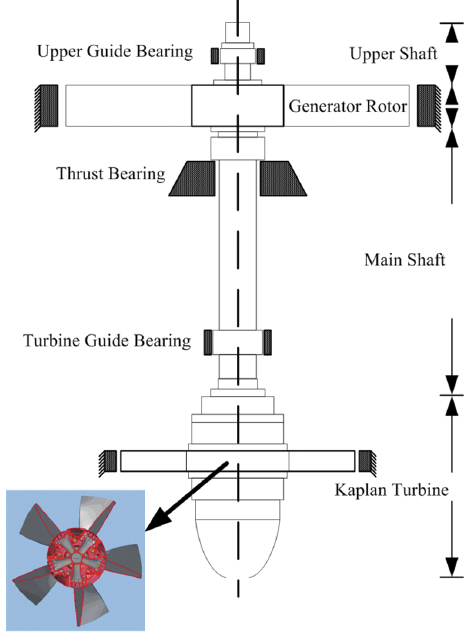
Fig. 1. Sketch of shaft system for 125 MW hydro-units in Gezhouba Hydropower